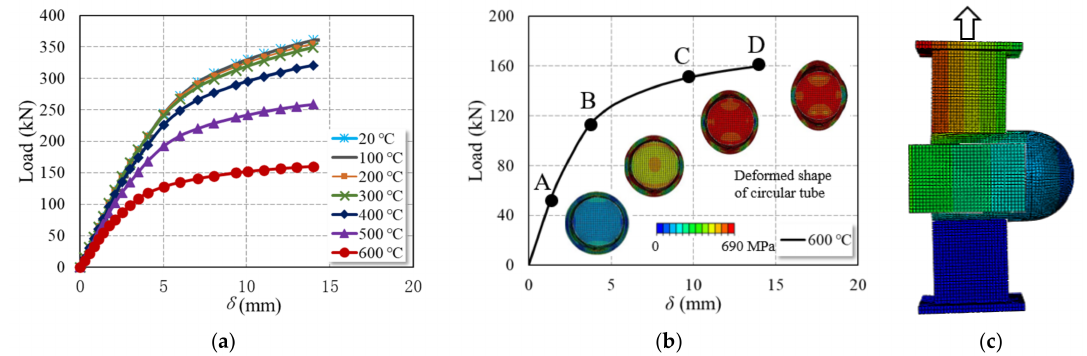
Figure 11. Effects of elevated temperatures on the load–displacement curves of specimen N1 under tension: ( a ) load–displacement curves; ( b ) failure process; ( c ) deformed shape corresponding to point C.